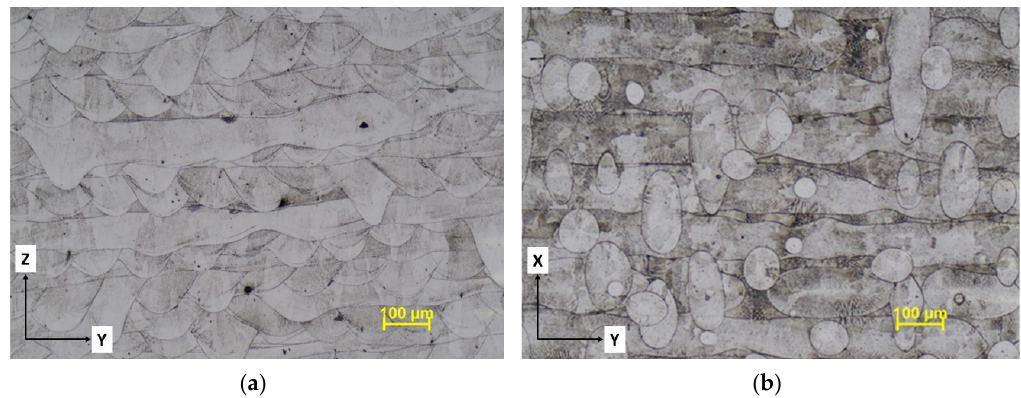
Figure 15. Microstructure of AM IN 625 in as-built condition parallel ( a ) and orthogonal to the build direction ( b ).